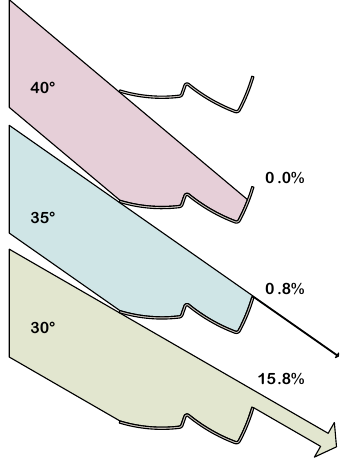
Figure 9. Geometric estimation of direct transmission through the louver system in its design geometry ( V2 ) at selected incident